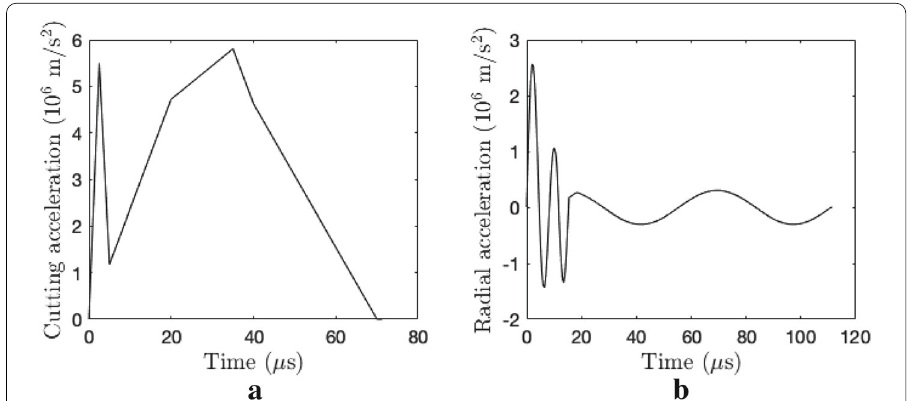
Fig. 4 Acceleration history of one node of the numerical simulation of linear pyrotechnical cutting. a Ignition in the cord of pyrotechnic cutting, b shock wave in the